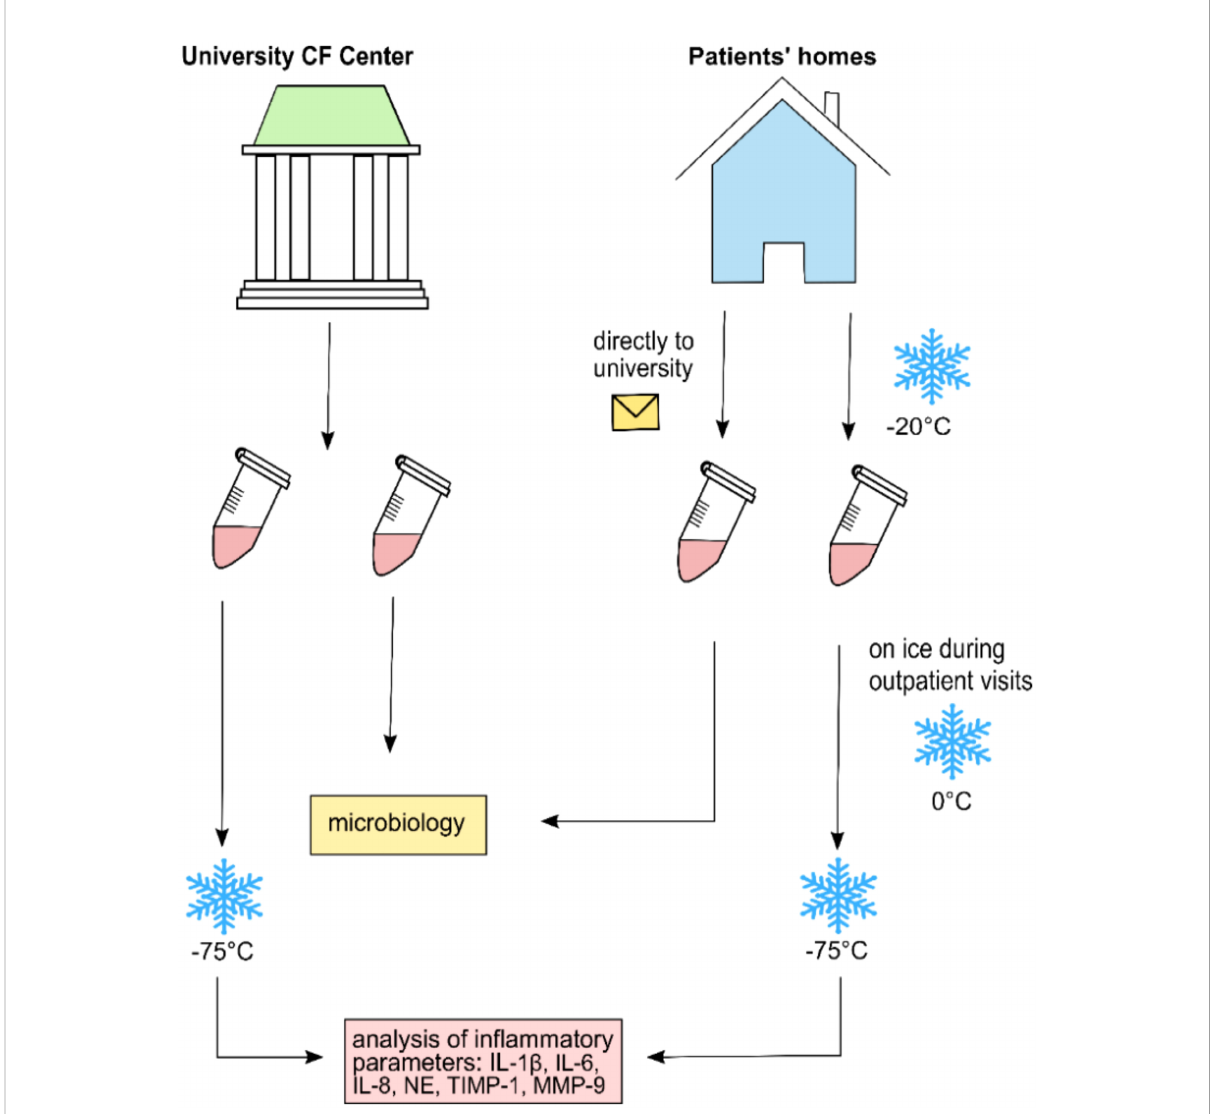
FIGURE 1 Collection and transference procedure for nasal lavage fl uid samples analyzed in this